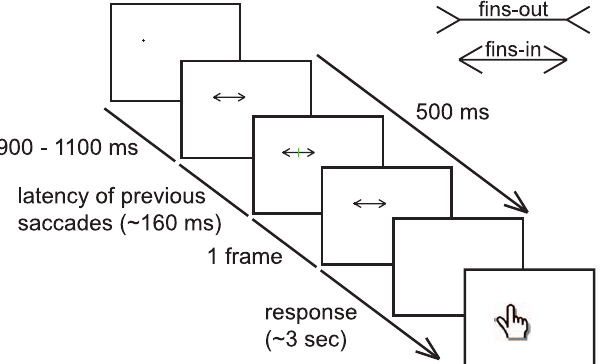
one of the two configurations of the Mu¨ller-Lyer illusion (upper right corner) appears on the screen (and remains visible for 500 ms). Around the time at which the participant makes a saccade to the right end of the shaft of the Mu¨ller-Lyer figure (about 160 ms after the figure appears), a vertical green bar is presented on the screen for one frame. Participants indicated where they had seen the bar by touching that location with their index finger.